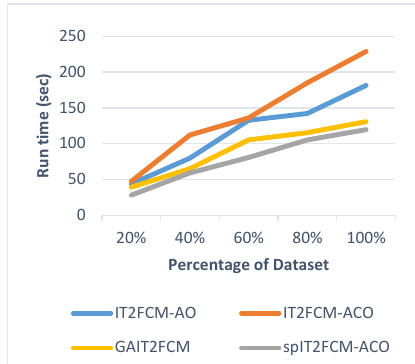
Figure 7. Analysis of run time for different percentages of forest dataset.